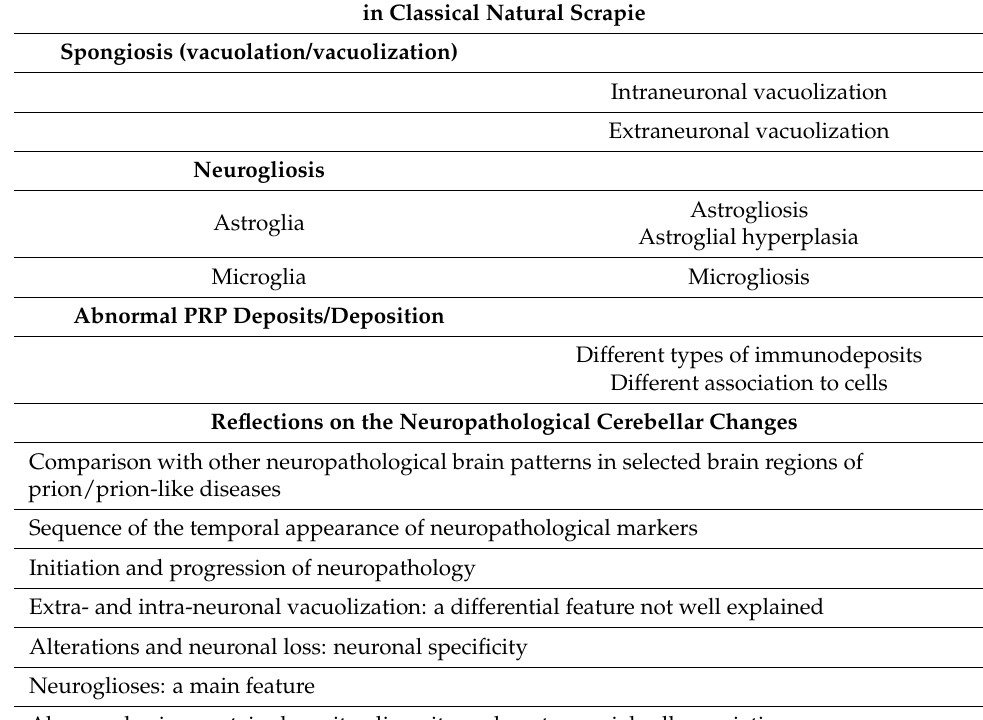
Reflections on the Neuropathological Cerebellar Changes Comparison with other neuropathological brain patterns in selected brain regions of prion/prion-like